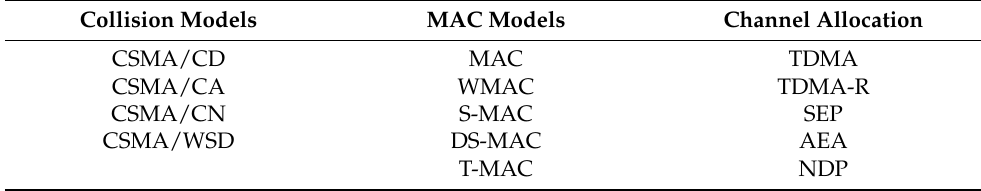
Table 3. Collision models and MAC models